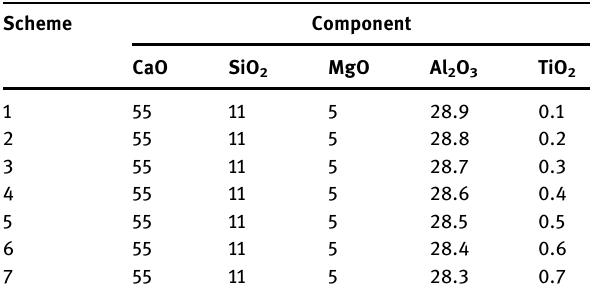
Table 2: Mass percentage of di ff erent components in the re fi ning slag, % Scheme